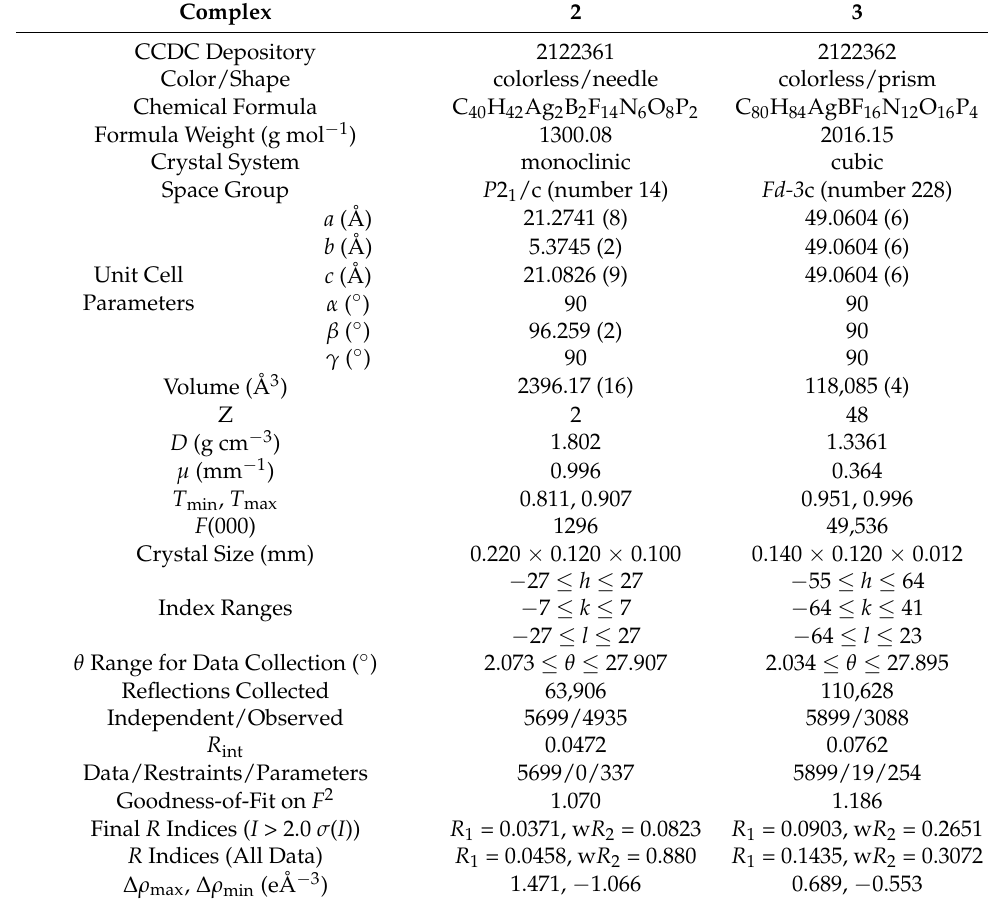
Table 1. Crystal data and structure refinement parameters for complexes 2 and 3